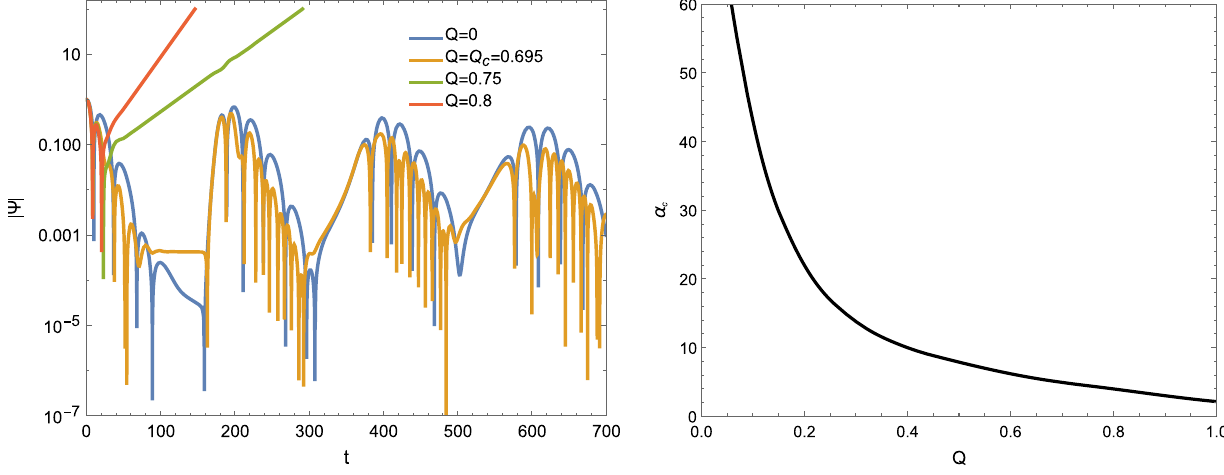
Fig. 4 Left: time evolutions of the scalar field perturbation in the linear level for α = 5 . 0 , B = 0 . 1 and various values of Q . Initial data of the − ( x − xc ) 2 perturbation is (cid:17)( t = 0 , x ) ∼ e 2 σ 2 with x c = 6 . 0 and σ = 6 . 0. Right: critical value of the coupling constant α c versus Q for fixed B = 0 .